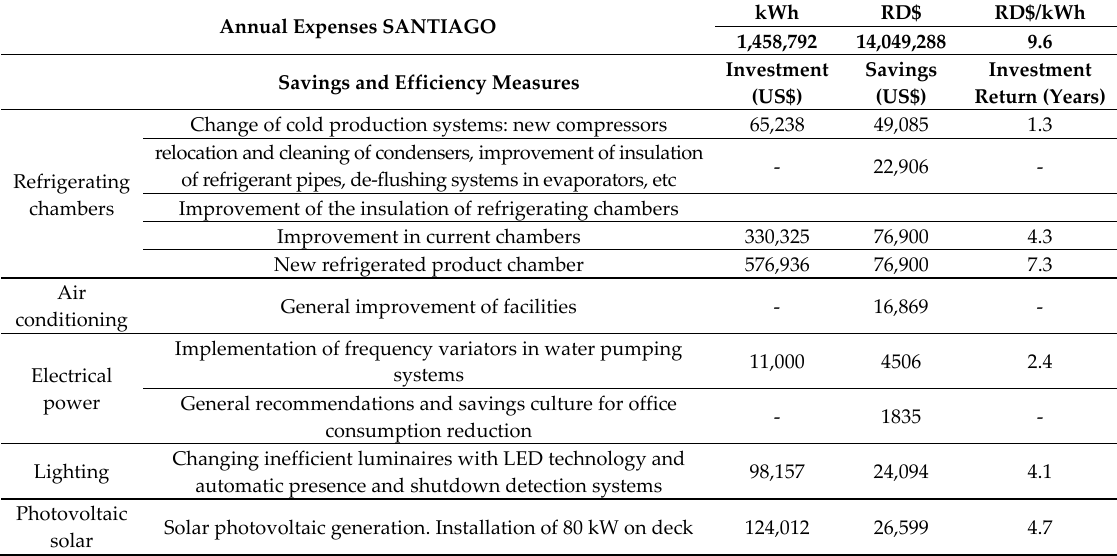
Table 2. Savings and efficiency measures in Santiago and all